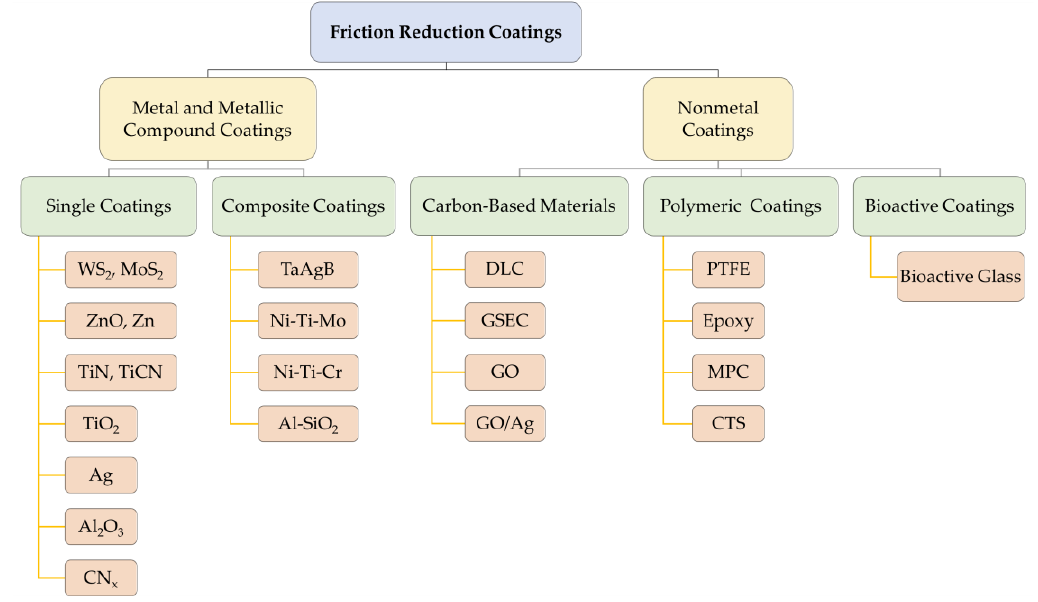
Figure 2. Summary of friction reduction coating materials. WS 2 : tungsten disulfide; MoS 2 :